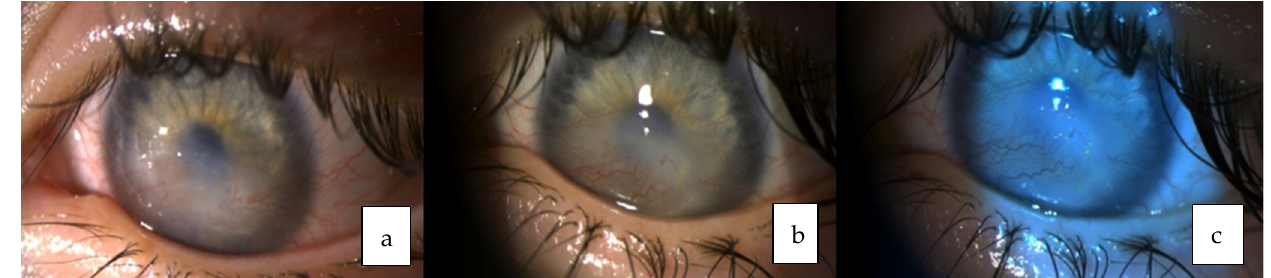
Figure 4. ( a – c ) Left eye weekly and ( d ) eight weeks after starting treatment with Cenegermin eye drops.